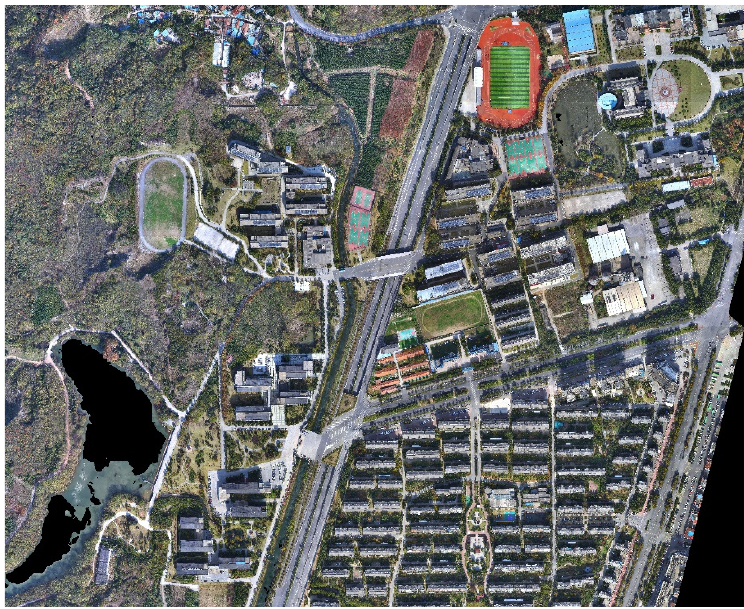
Figure 1. Image map of the study area.